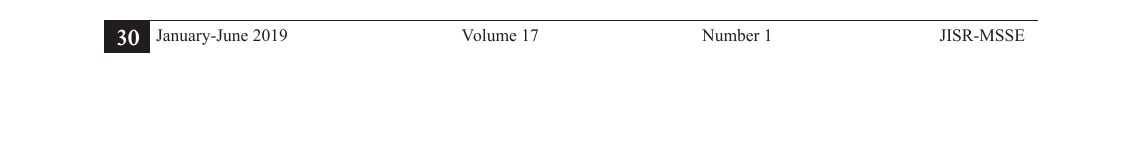
Source: World Development